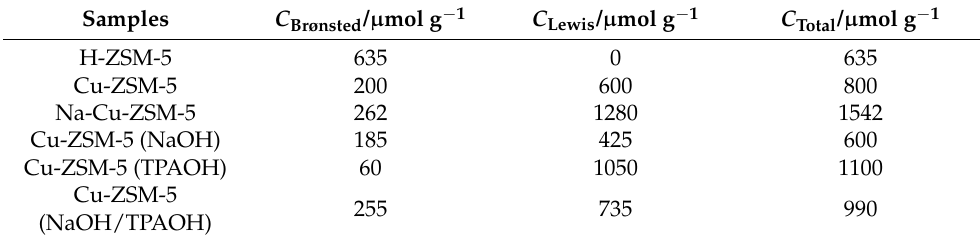
Table 2. Acidic properties of the samples determined from pyridine adsorption: concentration of Brønsted and Lewis sites, respectively ( C Brønsted , C Lewis ), total concentration ( C Total ). Samples C Brønsted / µ mol g − 1 C Lewis / µ mol g − 1 C Total / µ mol g − 1 H-ZSM-5 635 0 635 Cu-ZSM-5 200 600 800 Na-Cu-ZSM-5 262 1280 1542 185 425 600 60 1050 1100 735